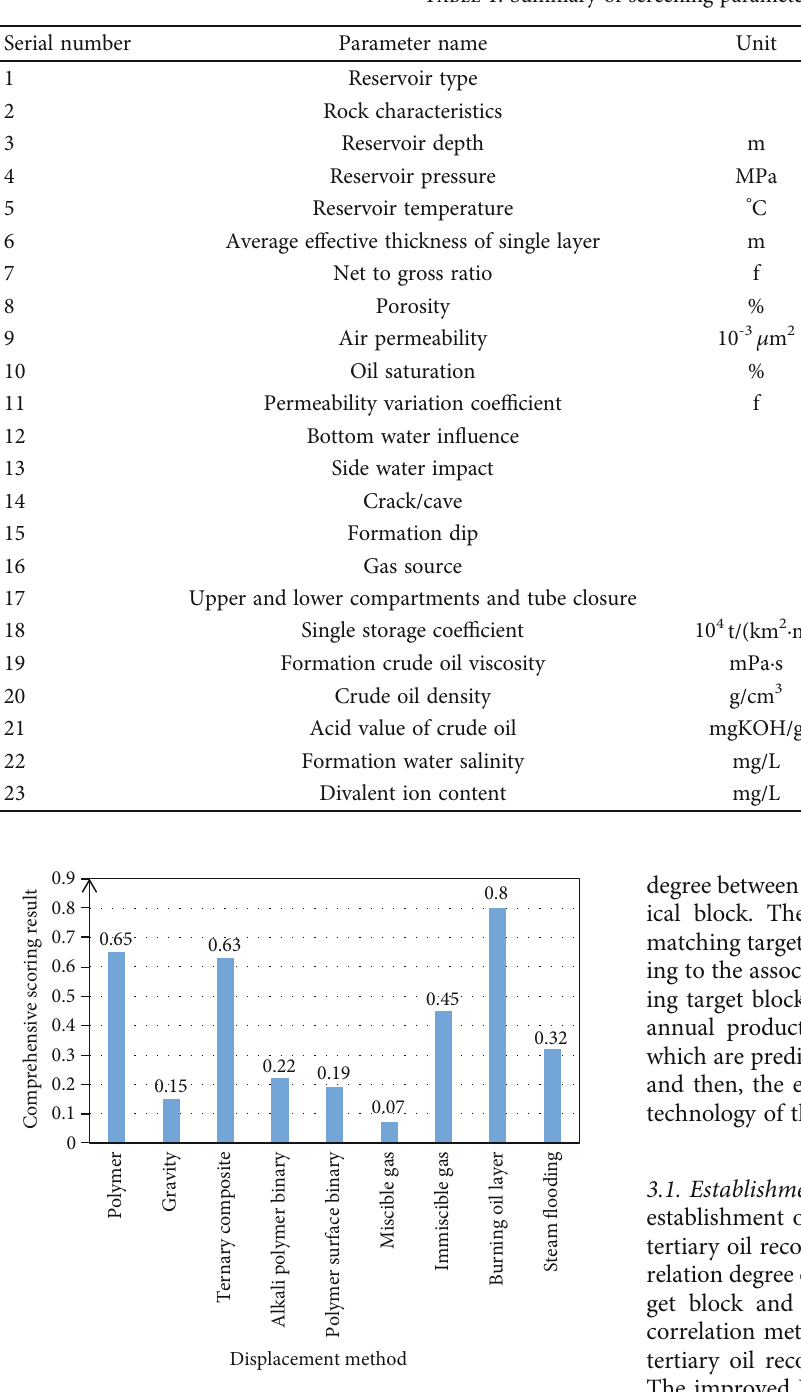
Figure 2: Comprehensive scoring results of displacement method